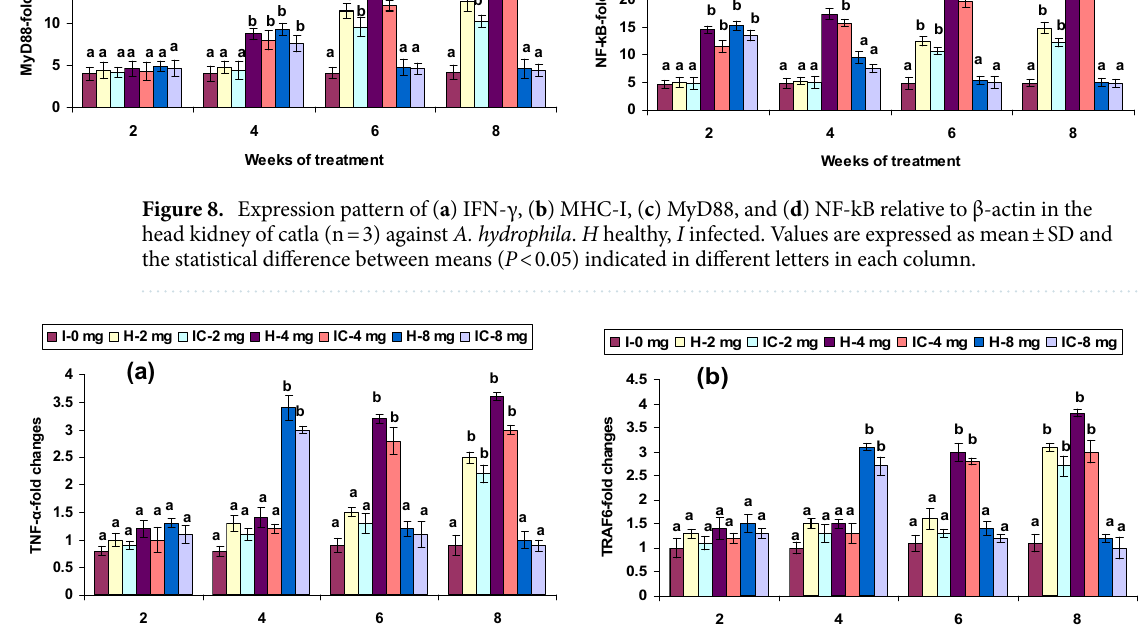
Figure 9. Expression pattern of ( a ) TNF-α and ( b ) TRAF6 relative to β-actin in the head kidney of catla (n = 3) against A. hydrophila . H healthy, I infected. Values are expressed as mean ± SD and the statistical difference between means ( P < 0.05) indicated in different letters in each